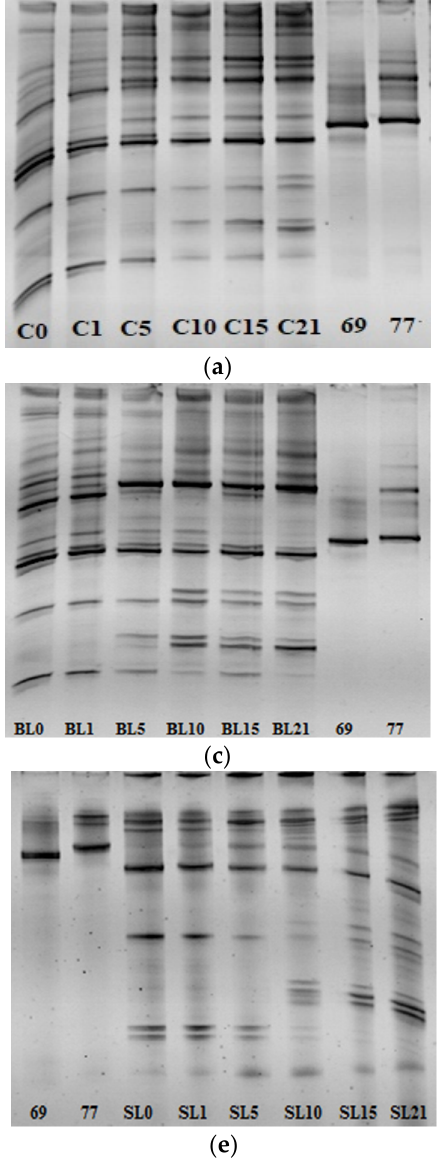
Figure 4. The LAB diversity during the tarhana dough fermentation. ( a ) Control dough fermented spontaneously; ( b ) BP dough fermented with B. cereus ATCC 11778 and P. acidilactici PFC69; ( c ) BL dough fermented with B. cereus ATCC 11778 and L. lactis PFC77; ( d ) SP dough fermented with S. aureus ATCC 29213 and P. acidilactici PFC69; ( e ) SL dough fermented with S. aureus ATCC 29213 and L. lactis PFC77. The numbers with code correspond to the fermentation day.